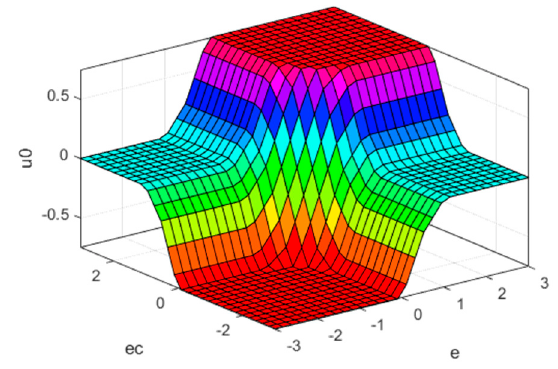
Figure 6. T-S FLC control surface.